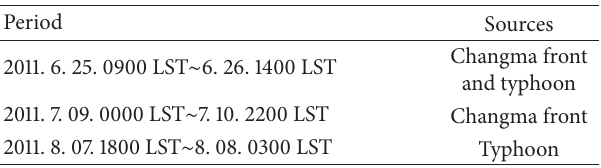
Table 1: Rainfall cases with different sources for the study. Period